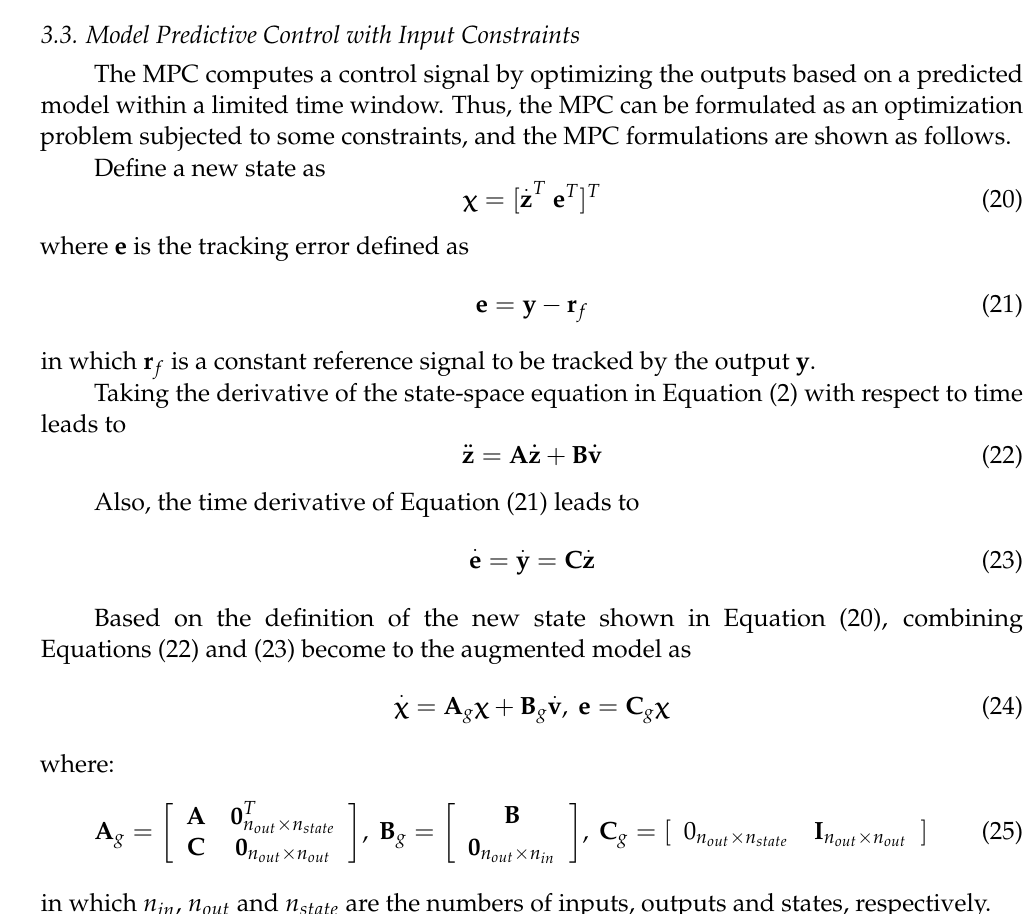
Figure 1. A signal approximated by using 2, 4 and 6 Laguerre